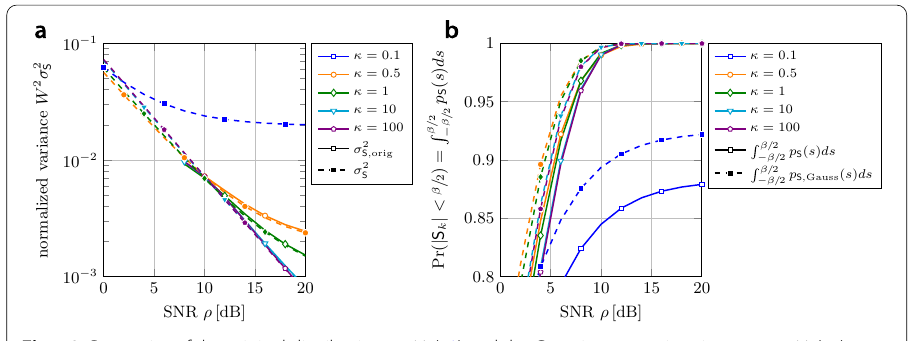
Fig. 10 Properties of the original distribution p S ( s ) (50) and the Gaussian approximation p S ,Gauss ( s ) (51). a Normalized variances σ 2 S ,orig of p S ( s ) and σ 2 S of p S ,Gauss ( s ) and b Pr (